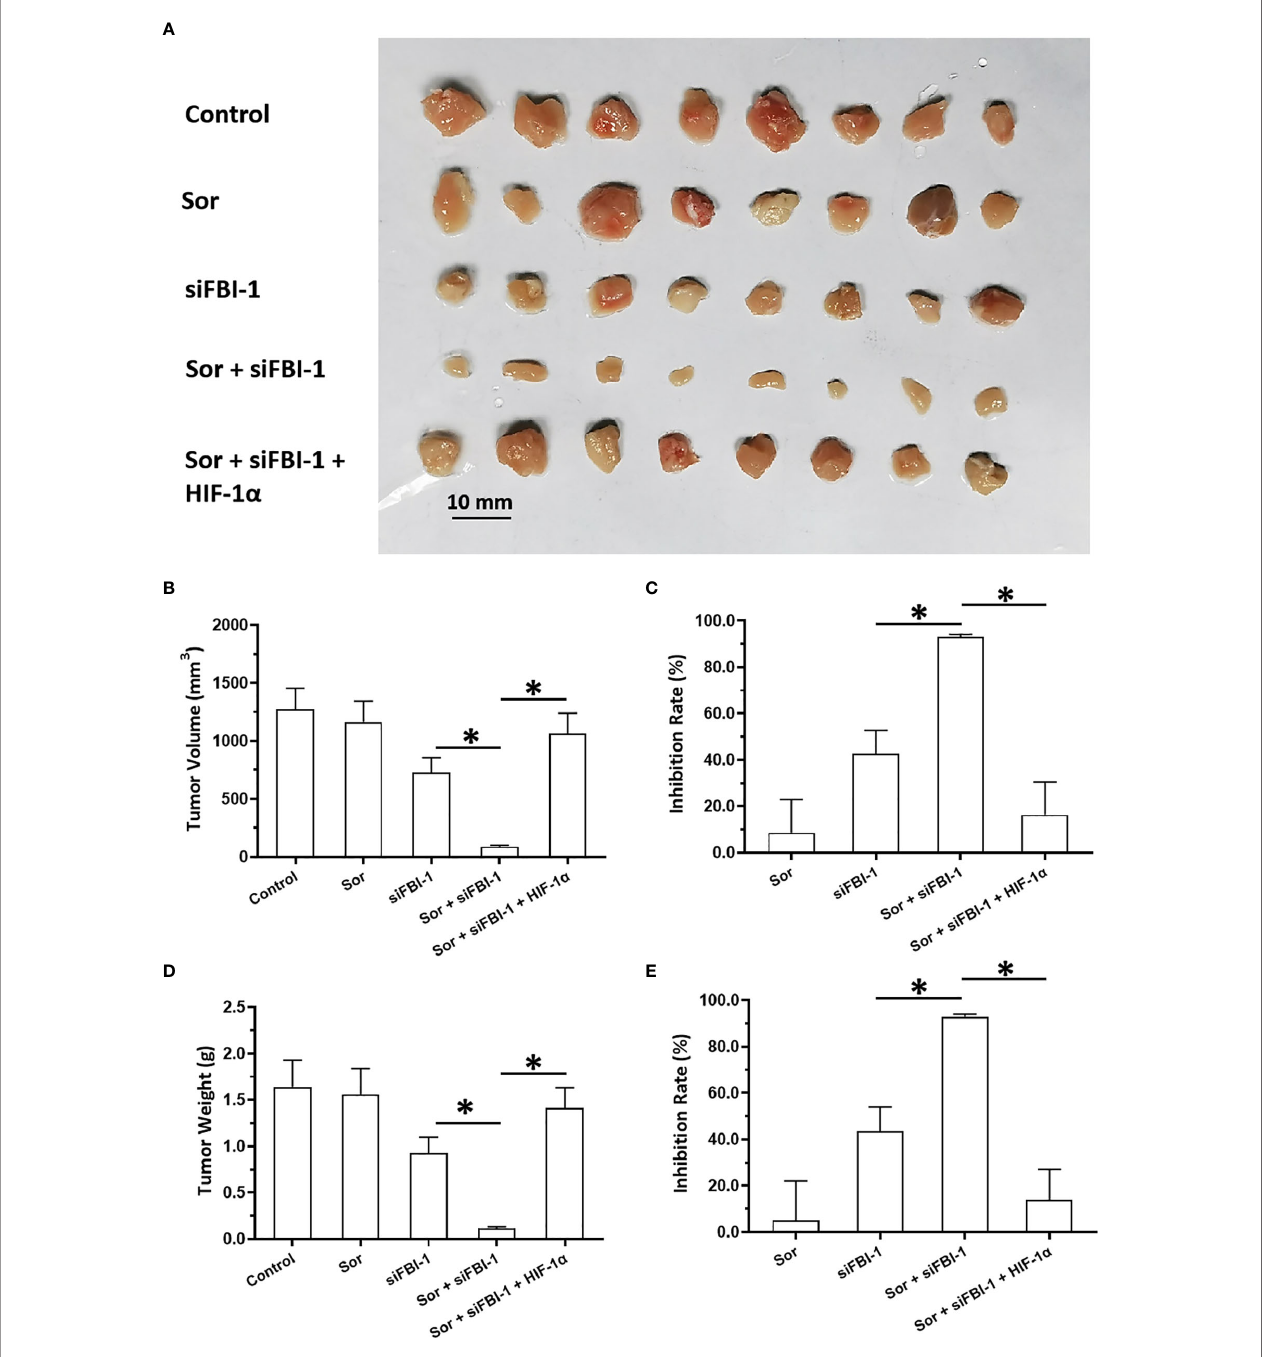
FIGURE 5 | siFBI-1 enhanced the sensitivity of MHCC97-H cells to sorafenib in a nude mice model. The MHCC97-H cells were transfected with vectors and injected into the nude mice to form the subcutaneous tumor models. The mice received the oral administration of 0.5 mg/kg Sorafenib. The results are shown as images (A) or the quantitative results (B – E) . *p <